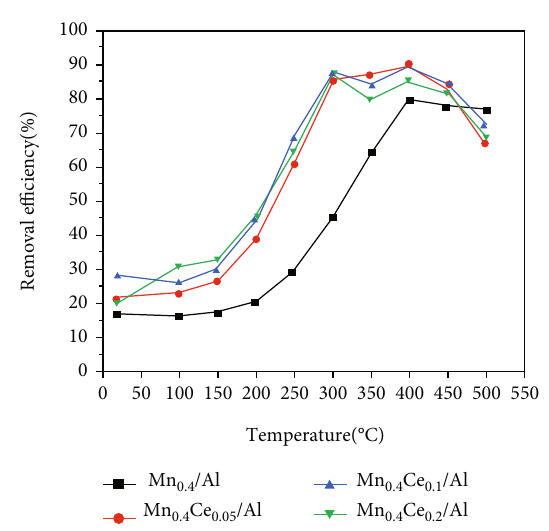
Figure 1: Schematic diagram of the experimental setup.